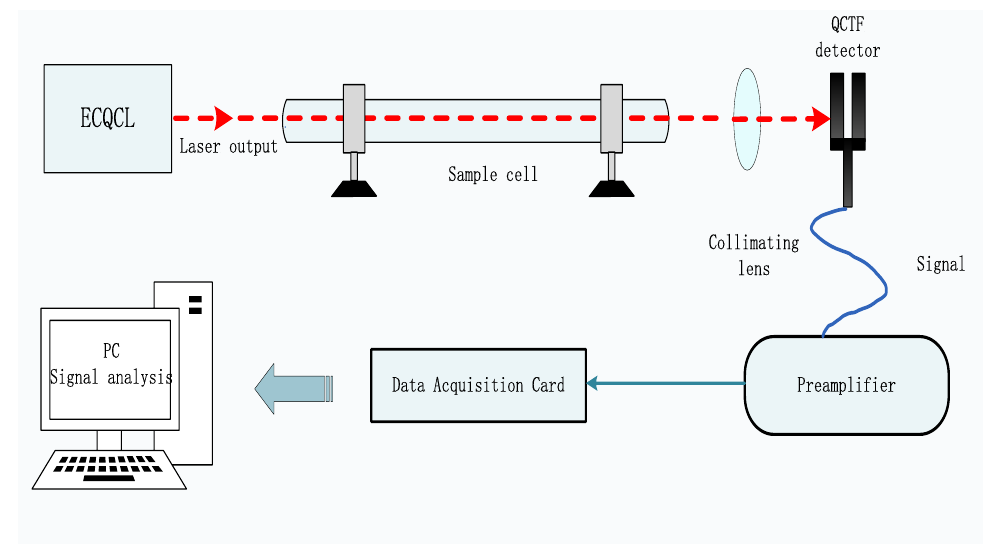
Figure 2. The schematic diagram of the ECQCL and QCTF-based gas detection system.